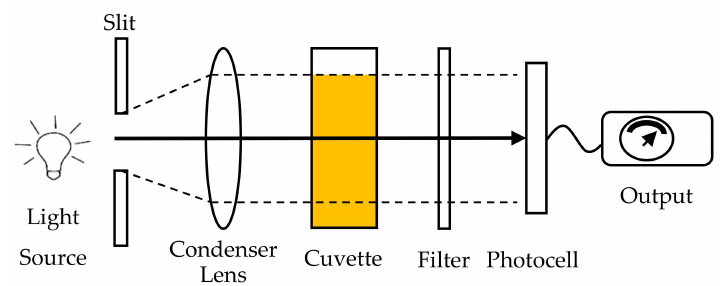
Figure 5. Photoelectric colorimeter diagram.